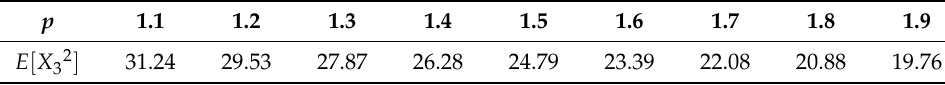
Table 8. Expected values of J ( X t ) with different orders p